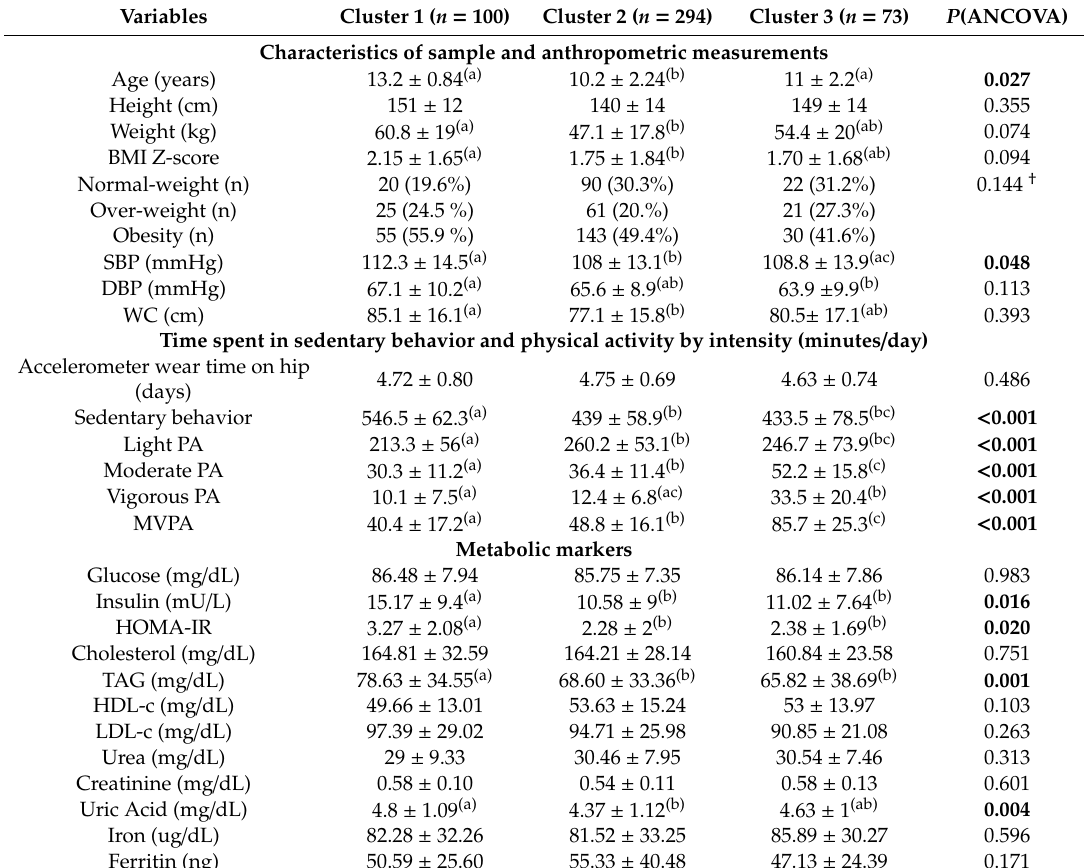
Table 1. Characteristics, anthropometry, time spent in sedentary behavior and physical activity intensity, and metabolic markers, by